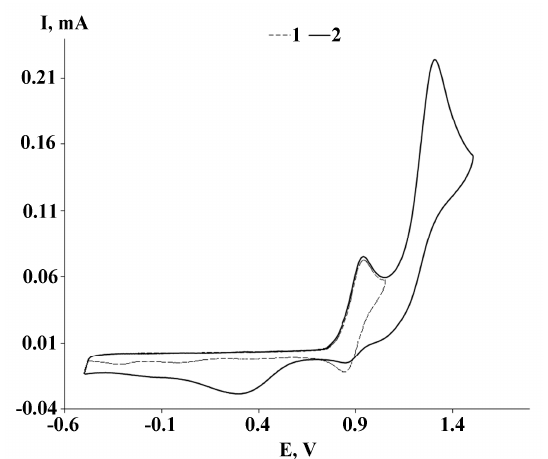
Figure 8. Cyclic voltammograms of compound 2 (in the potential switch from − 0.50 to 1.05 V—curve 1; in the potential switch from − 0.50 to 1.50 V—curve 2) (CH 3 CN, C = 4 mM, 0.15 M TBAP, scan rate 200 mV·s − 1 ).